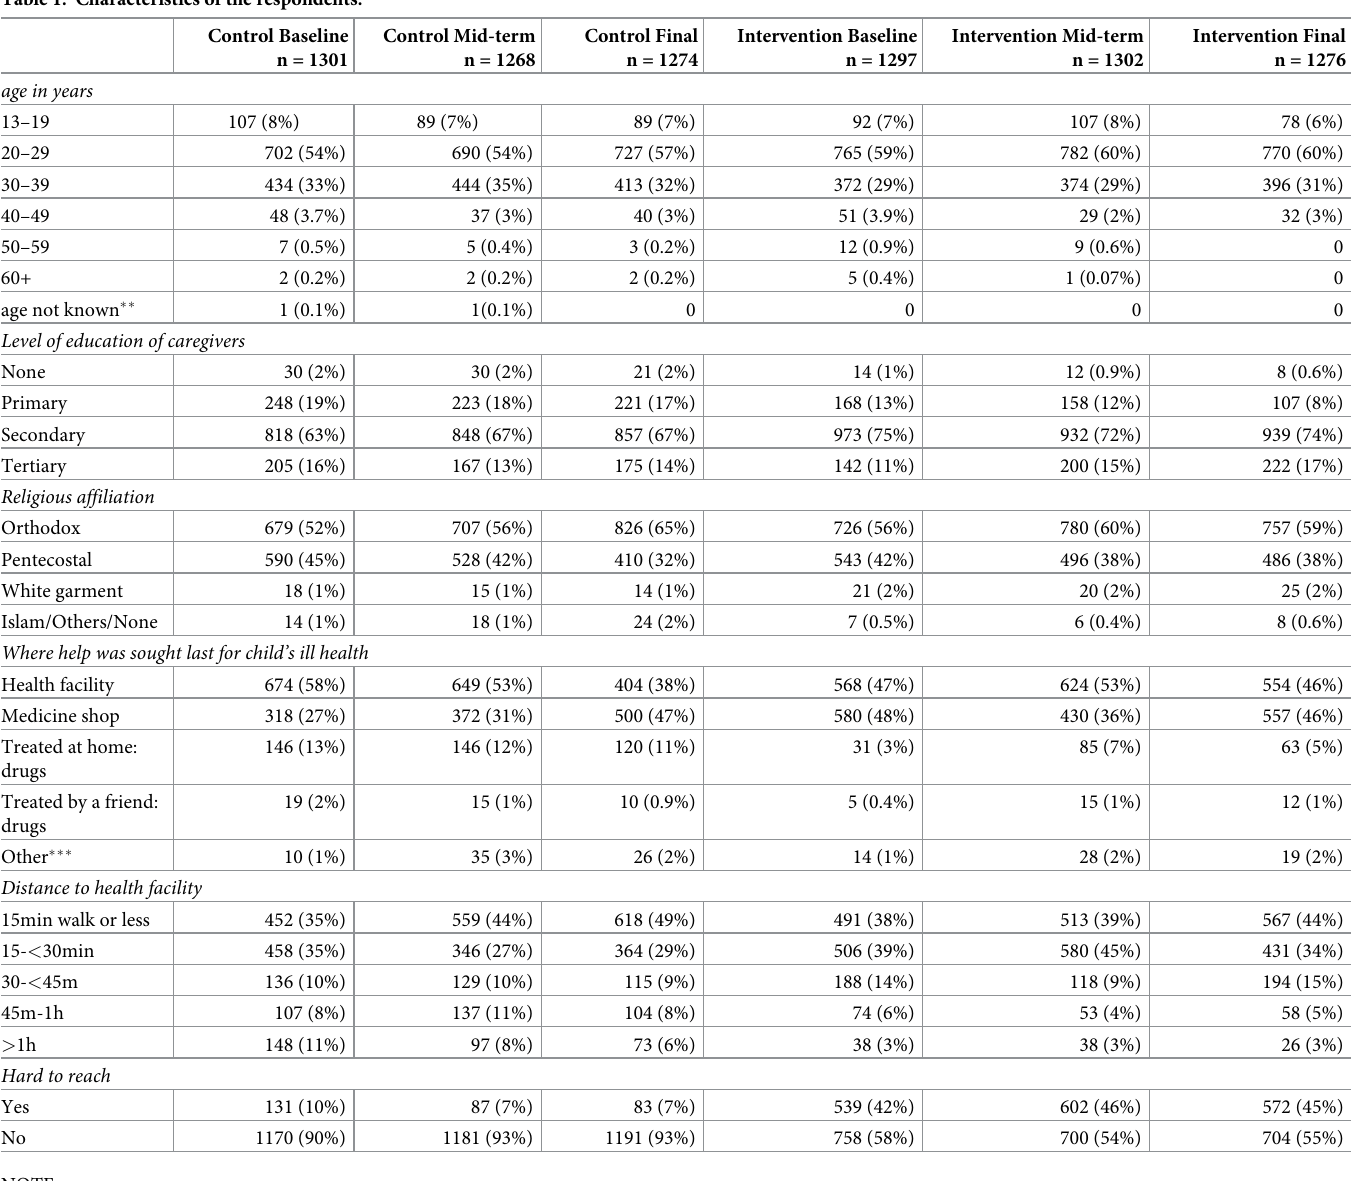
Table 1. Characteristics of the